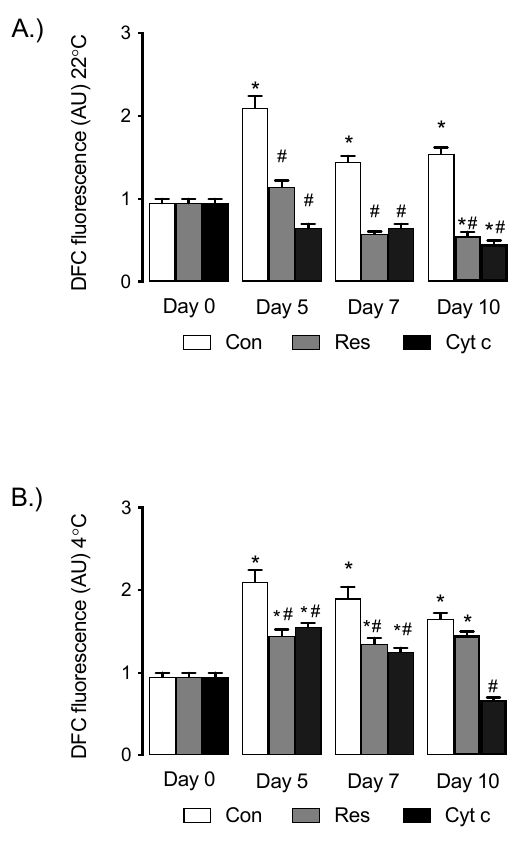
Figure 2. ( A ) Intracellular ROS production (measured as DFC fluorescence; arbitrary units [AU]) increases in platelets stored at 22 ◦ C and supplementation with Res or Cyt c reduces ROS production compared to untreated (control; Con) platelets. * p < 0.05 versus treatment-matched day 0, # p < 0.05 treatment group versus Con at same time point, n = 4 independent experiments. ( B ) Intracellular ROS production increases in platelets stored at 4 ◦ C, and supplementation with Res or Cyt c significantly reduces ROS production compared to Con platelets. * p < 0.05 versus treatment-matched day 0, # p < 0.05 treatment group versus Con at same time point, n = 4 independent experiments.